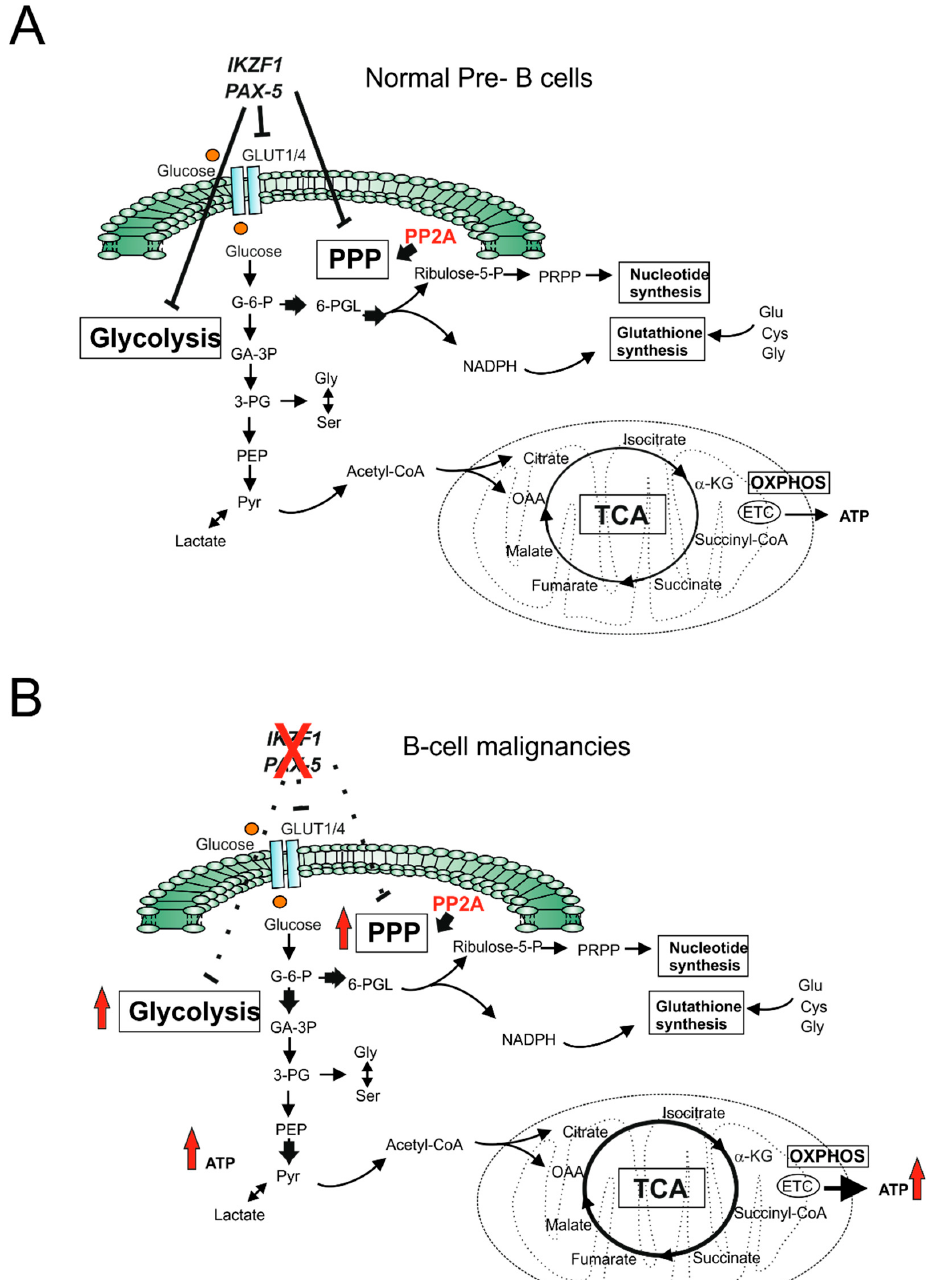
Figure 1. Transcriptional repression of glucose metabolism by metabolic gatekeepers prevents B-cell transformation and is lost during oncogenic signaling. ( A ) Gatekeeper transcription factors (PAX5, IKZF1) limit glucose consumption and the production of metabolites that fuel the tricarboxylic acid cycle (TCA), thus limiting the energy (ATP) production necessary for neoplastic transformation; ( B ) Genetic alterations leading to loss of PAX5 or IKZF1 gatekeeper functions allow an unrestricted consumption of glucose (glycolytic flux) and sufficient energy production to permit transformation. In B cells, protein phosphatase 2A (PP2A) is required in order to further enhance glucose utilization, which is also through the PPP pathway. Solid arrows indicate activity of the pathway; dashed lines indicate inhibited or weak activities. GLUT: glucose transporter; G-6-P: glucose-6-phosphate; GA-3P: glyceraldehyde-3-phosphate; 3-PG: 3-phosphoglycerate; 6-PGL: 6-phosho-gluconolactone; PEP: phosphoenolpyruvate; Pyr: Pyruvate; α -KG: alpha-ketoglutarate; Glu: glutamine; Cys: cysteine; Gly: glycine; Ser: serine; ribulose-5-P: ribulose-5-phosphate; PRPP: phosphoribosyl pyrophosphate; OAA: oxaloacetate; PPP: pentose phosphate pathway; TCA: tricarboxylic acid cycle; OXPHOS: oxidative phosphorylation; ETC: electron transport chain.